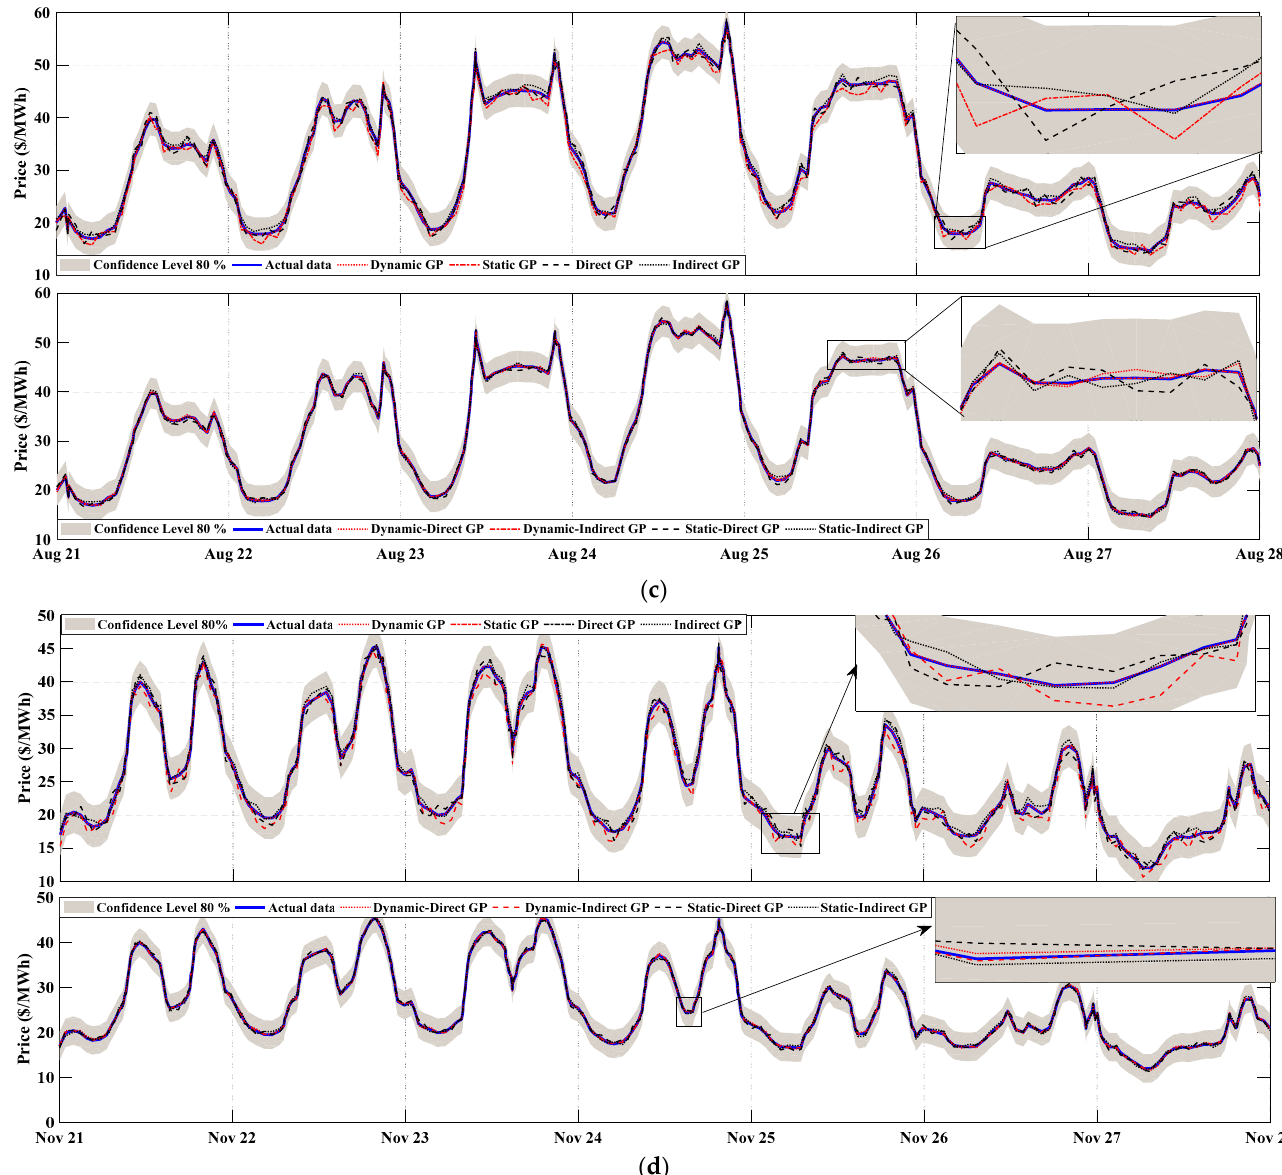
Figure 9. The forecasting of test data of EP using various models for the electricity market of Spain: ( a ) winter, ( b ) spring, ( c ) summer, ( d ) autumn.